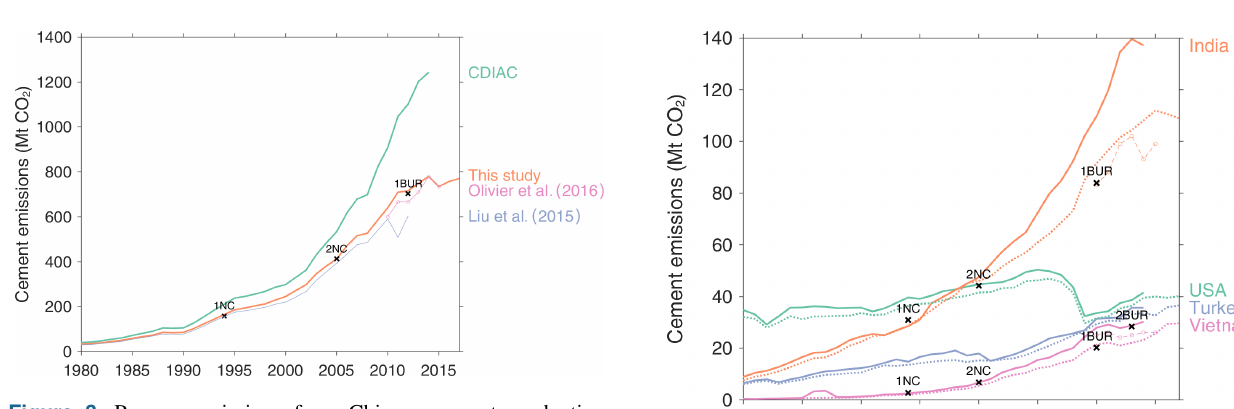
Figure 3. Process emissions from Chinese cement production, 1980–2017. 1NC refers to China’s first National Communication, 2NC the second National Communication, and 1BUR the first Bien- nial Update Report. Also shown are estimates from CDIAC (Boden et al., 2017), Liu et al. (2015) and EDGAR v4.3.2 FT2015. made by the IEA (2017) – before rebounding slightly to 0.69 in 2017.